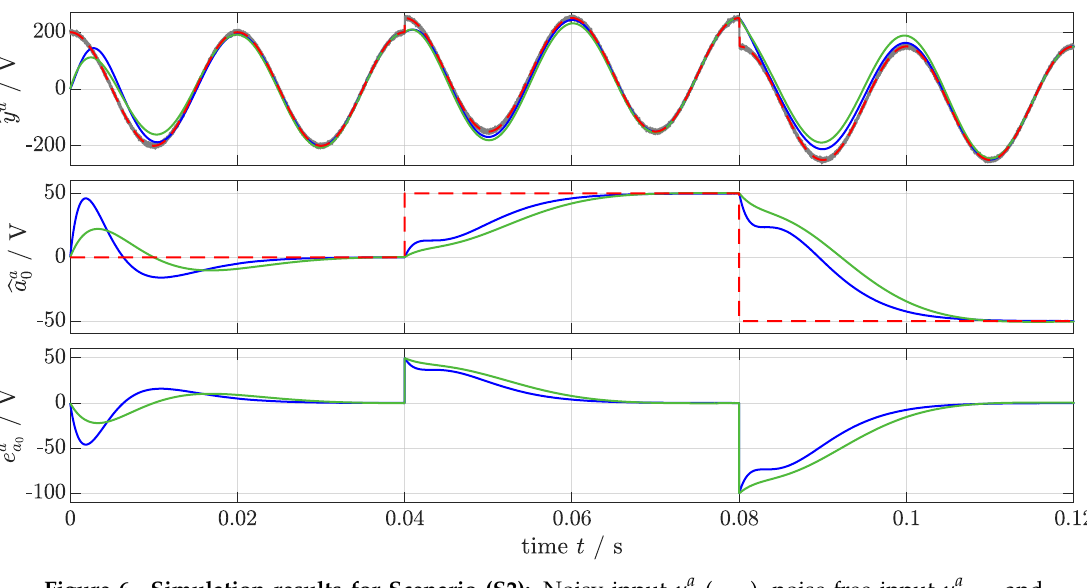
won , and (this paper: , [4]: 0